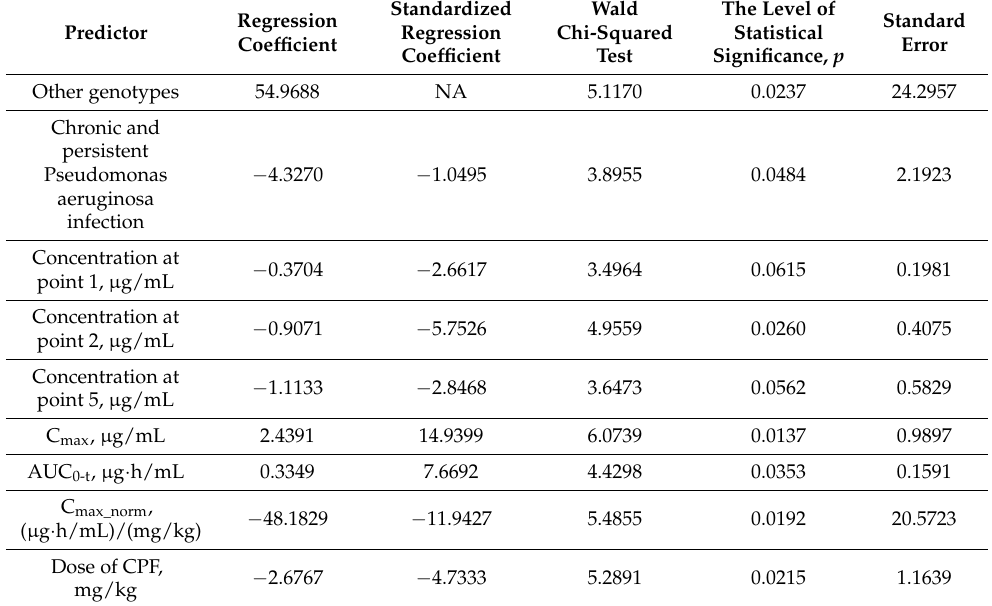
Table 18. Estimation of logistic regression parameters in patients with the F508del/F508del genotype and other genotypes. Standardized Wald Regression Predictor Regression Chi-Squared Coefficient Coefficient Significance, p